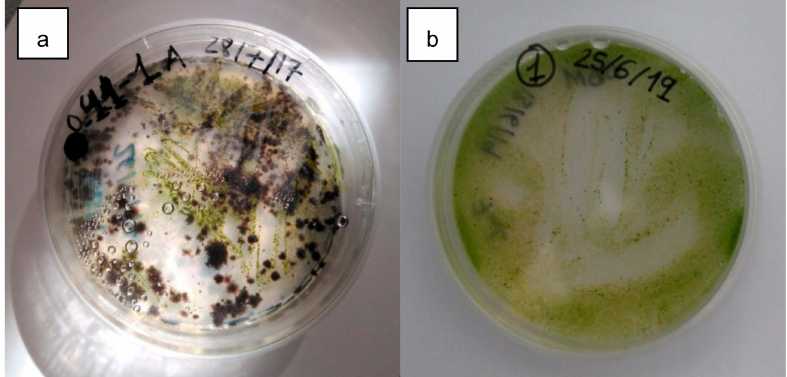
Figure 11. Microalgal cultures: ( a ) an initial culture using a sample is shown on the left; ( b ) a unialgal culture of Neochloris sp is shown on the right. Table 3. Species obtained from unialgal cultures using samples collected in the Alhambra and Generalife. The fountain numbers (Tables 1 and 2) from which the cultures came are indicated in the left column. Fountains Green Algae Fountains Cyanobacteria Neochloris